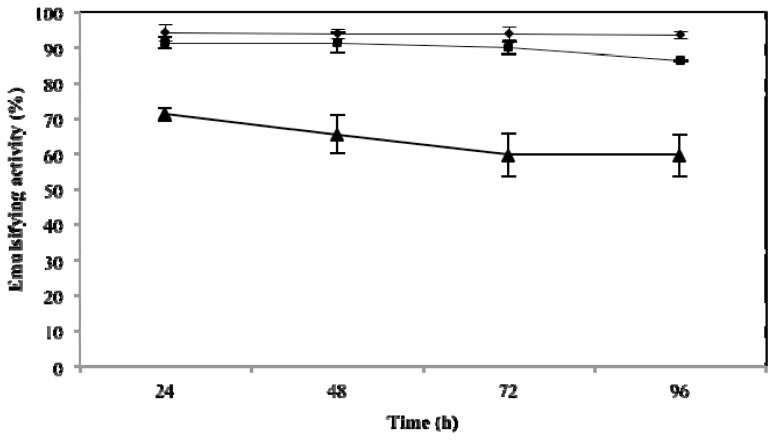
Emulsifying activity of microemulsan on motor oil at various salinities up to 96 h. 3.5% (●), 5% (■) and 10% (▲) NaCl concentration. Values represent means ± SD (n = 3).